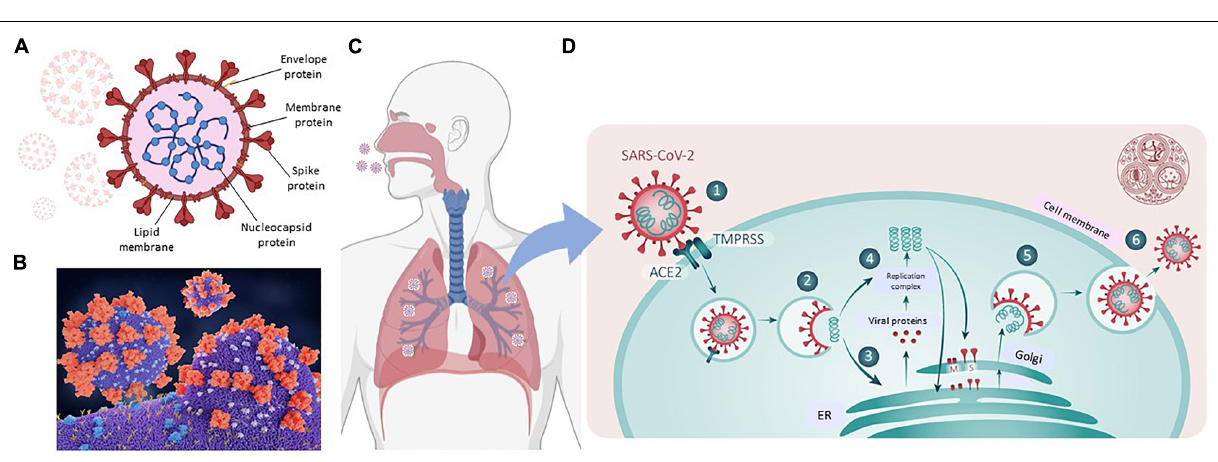
FIGURE 2 | SARS-CoV-2 and COVID19. (A) Representation of SARS-CoV-2 virus. (B) A molecular model showing the virus with spike proteins (red) and ACE2 (angiotensin converting enzyme 2) receptor (blue) on host cell surface. From Juan Gaertner/Science Photo Library, accessed 8/11/2020. (C) Covid19 entry via airways. (D) scheme showing TMPRSS activation of virus, followed by its internalization, processing and replication, Adapted from Ward P. et al. (2020). Available at: https://www.fpm.org.uk/blog/covid-19-sars-cov-2-pandemic. Accessed